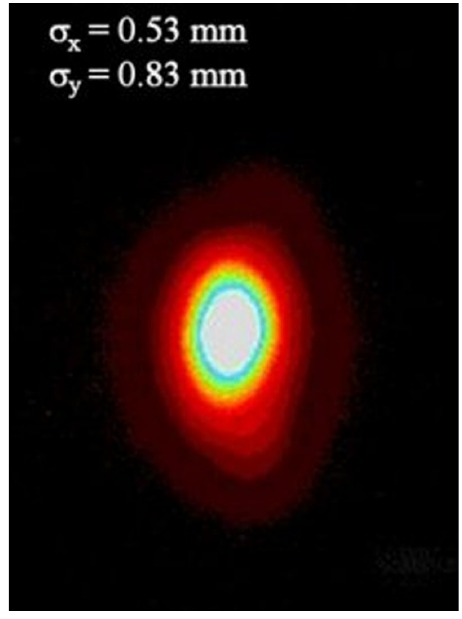
FIG. 21. Measured beam spot at the linac